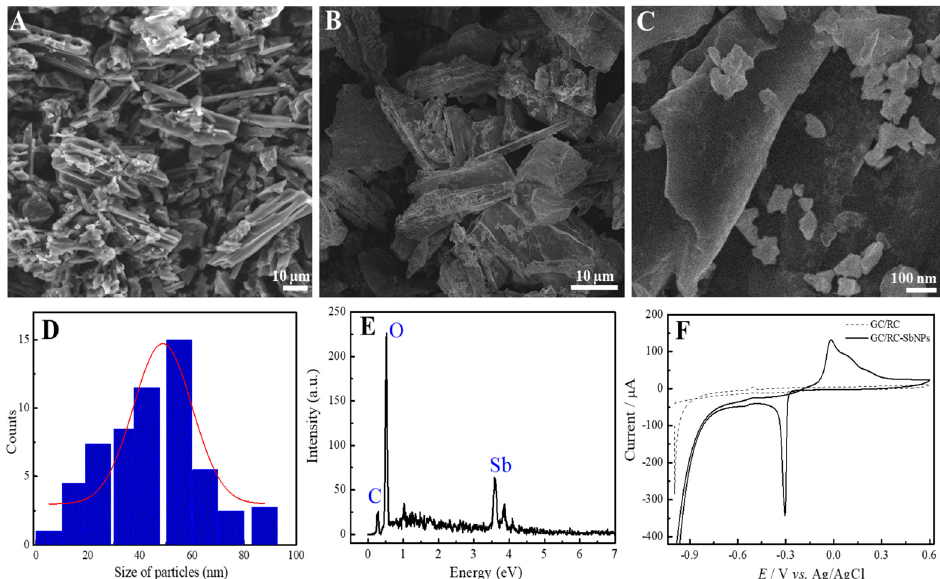
Figure 1. Morphological characterization by FEG-SEM of ( A ) RC, ( B ) RC-SbNPs and ( C ) SbNPs at higher magnitude. ( D ) Size distribution of Sb nanoparticles. ( E ) EDS spectra of RC-SbNPs. ( F ) Cyclic voltammetry of the GC/RC-SbNP (dashed line) and GC/RC-SbNP (solid line) electrodes in 0.5 mol L − 1 HCL, with scan rate of 50 mV s − 1